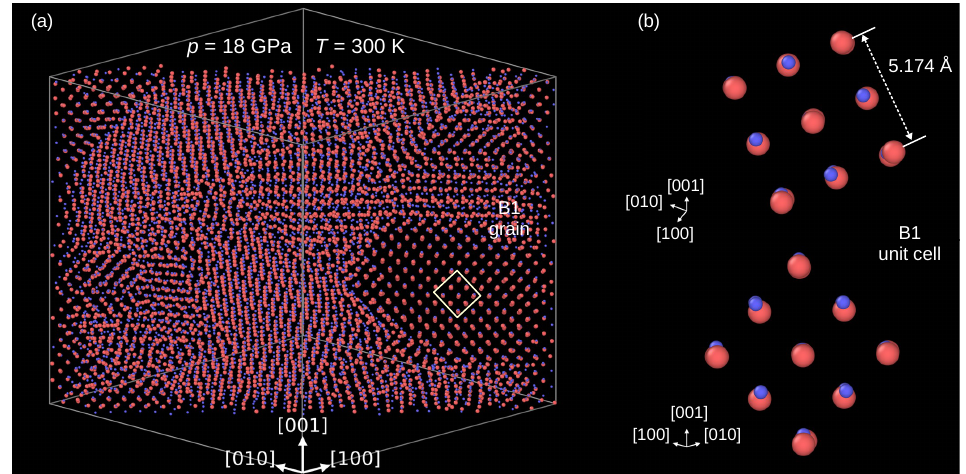
Figure 2. The InP crystal after the B3 → B1 phase transformation. ( a ) Multi-grain structure of the the modeled crystal. ( b ) Details of atomic arrangements in the B1 phase. Atoms: In—coral, P—blue.